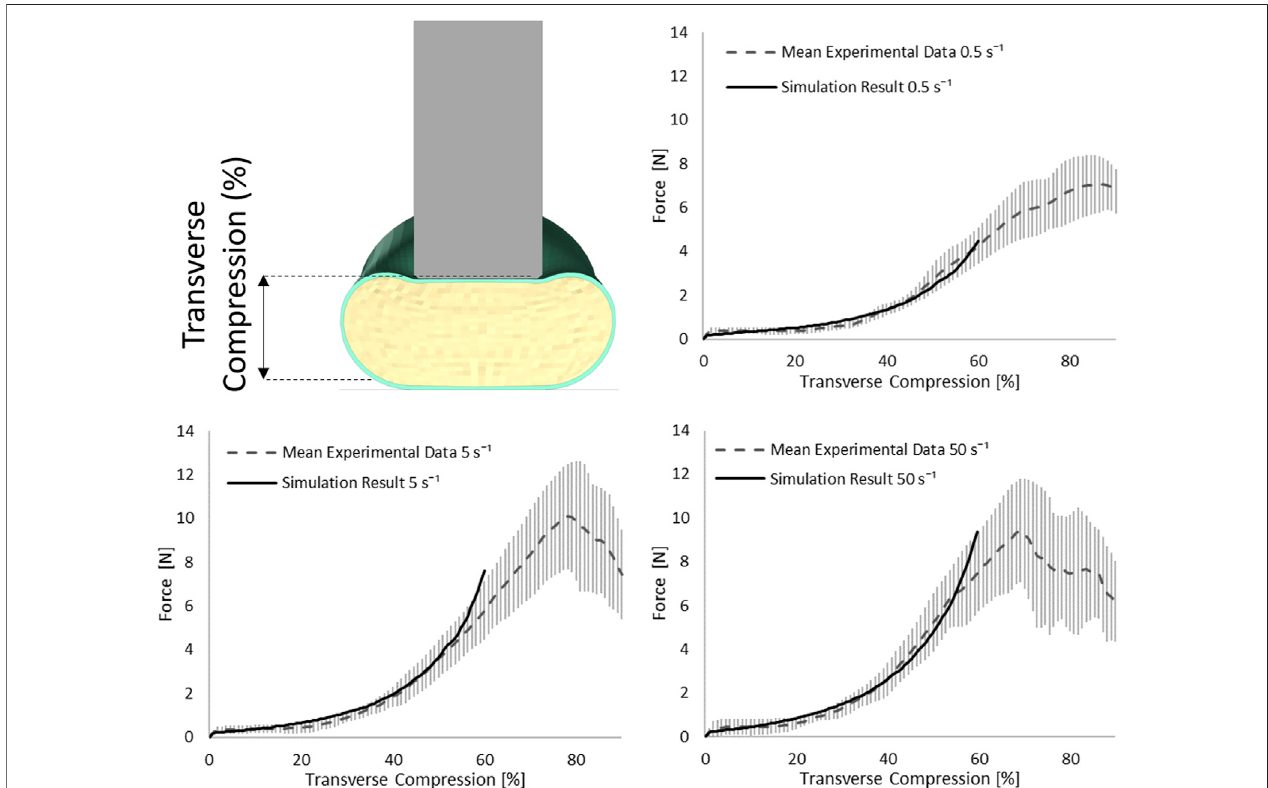
FIGURE6| Stress-transversecompressionplotsfortheindentationsimulationsforthreeexperimentalstrainrates0.5,5,and50 s − 1 ;errorbarsrepresentstandard deviation of the experimental data (Fradet et al., 2016).